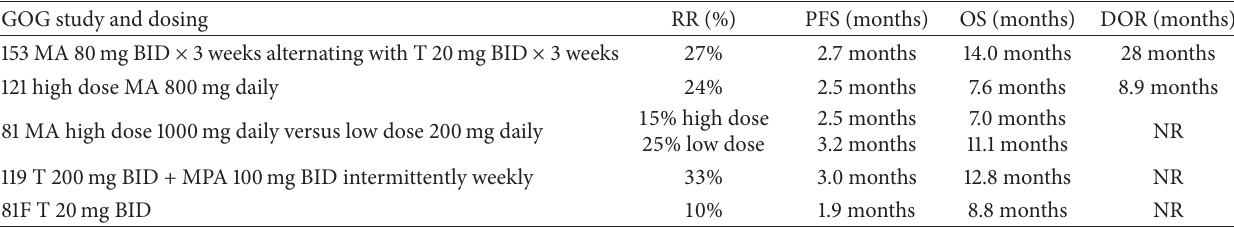
Table 10: GOG trials of hormone therapy in endometrial